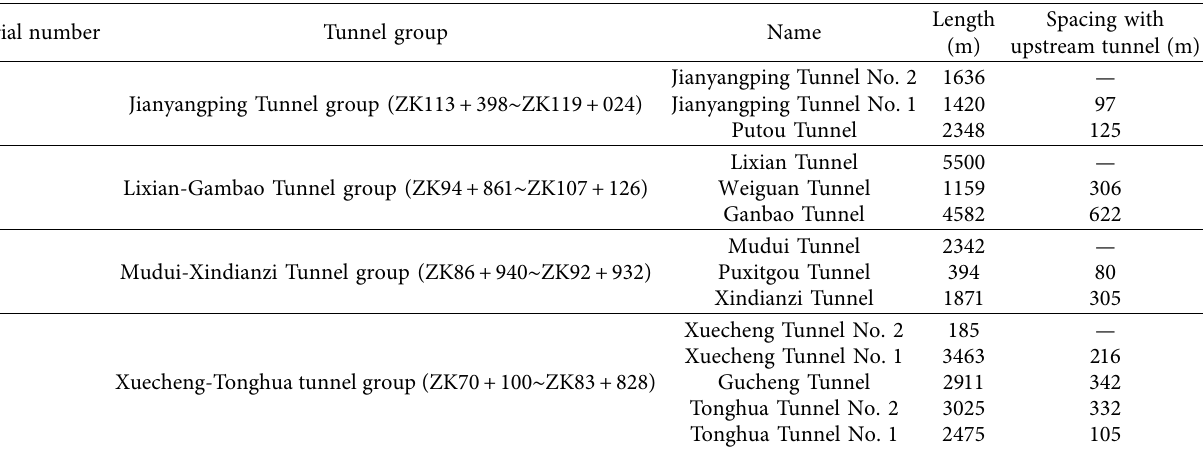
Table 4: Tunnel group